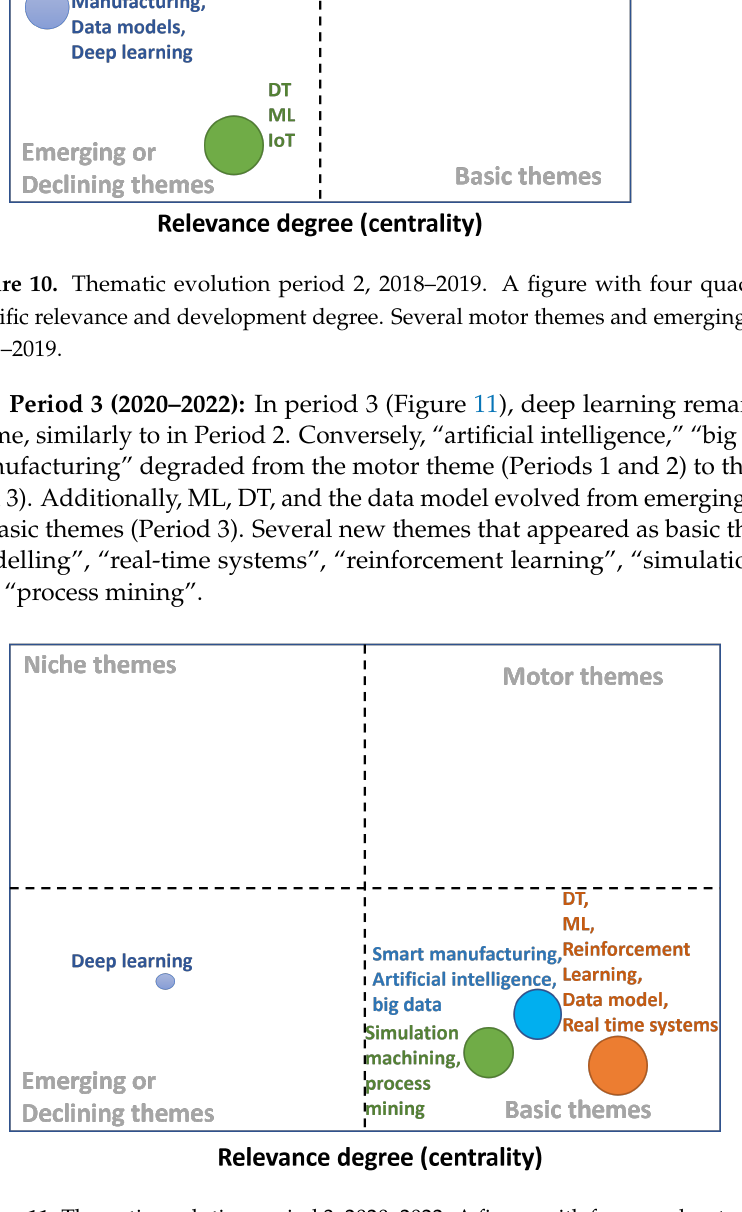
Figure 11. Thematic evolution period 3, 2020–2022. A figure with four quadrants representing specific relevance and development degree. Several basic themes in period 3,